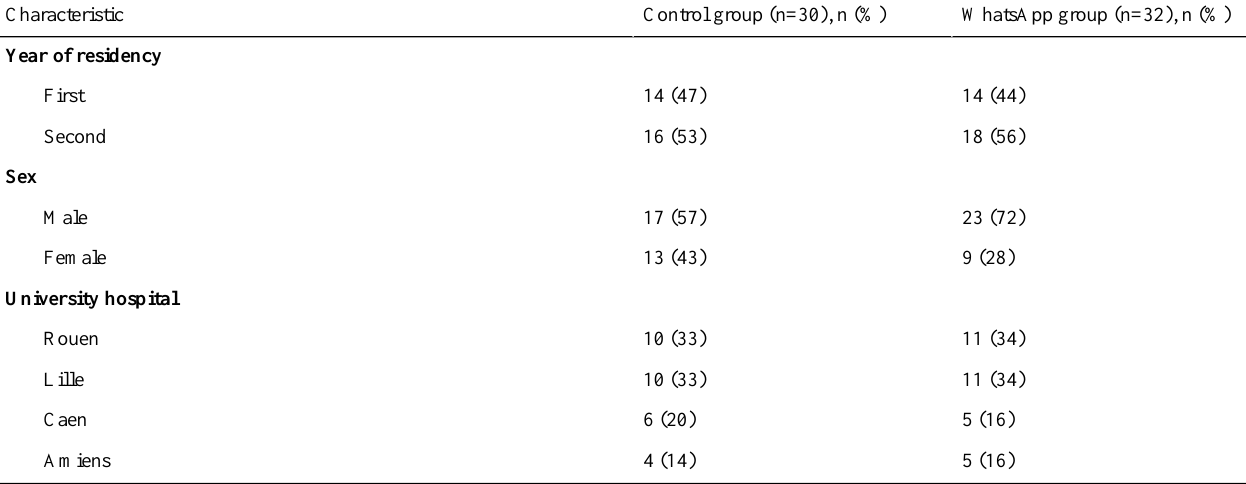
Table 2. Demographic characteristics of the